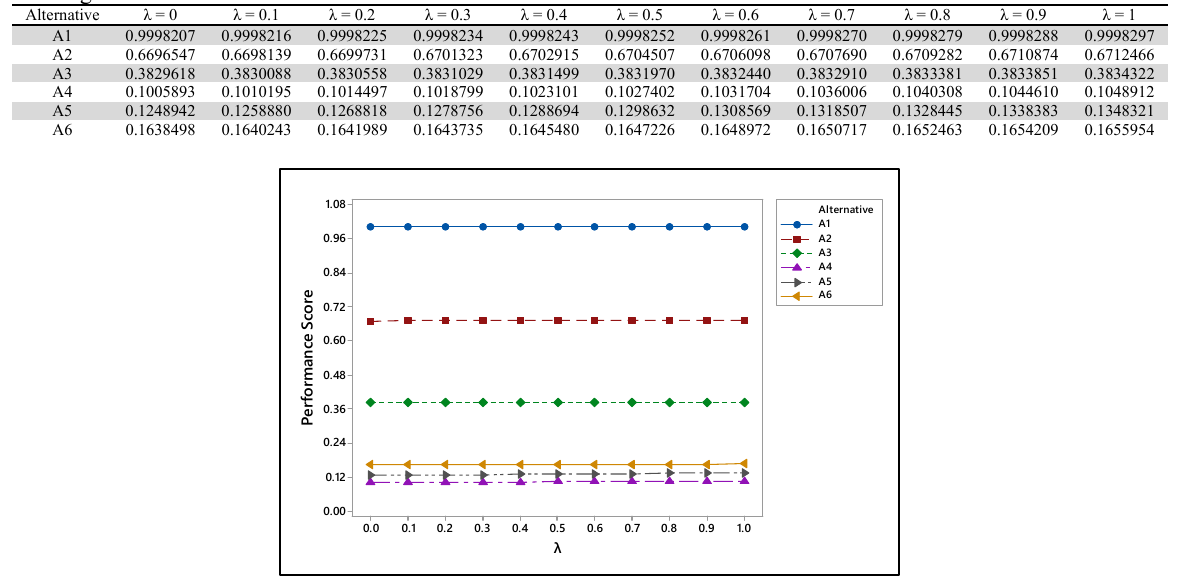
Fig. 12. Variation of performance scores for different λ values Fig. 12 highlights the effect of the varying values of λ on the performance scores and ranking in WASPAS method. It is interesting to note that the ranking of all alternatives remains constant over the considered range of λ